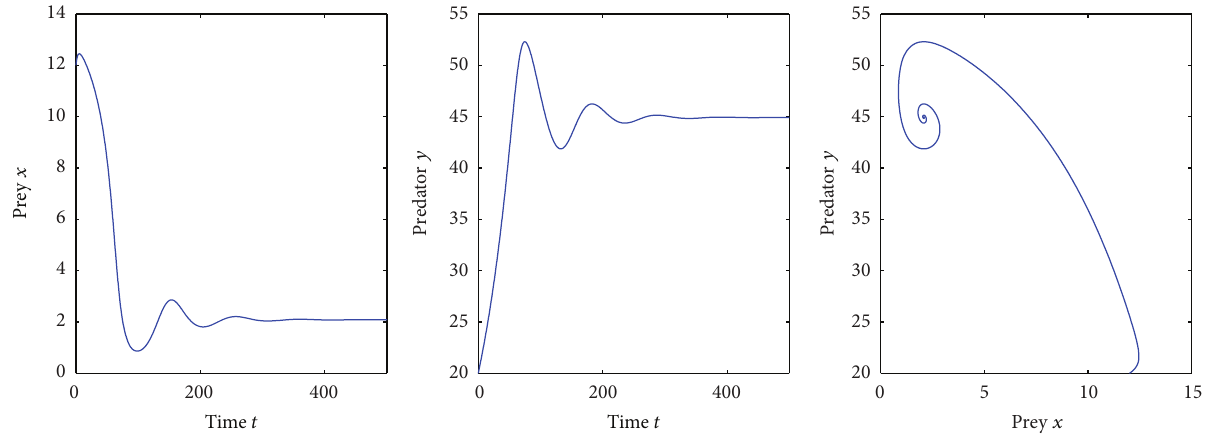
Figure 7: The time series and the portrait phase of the system (1) when 𝑟 = 0.5 , 𝐾 = 15 , 𝑎 = 100 , 𝜇 = 0.5 , 𝐷 = 0.01 , and (𝑥(0),𝑦(0)) = (12, 20) .